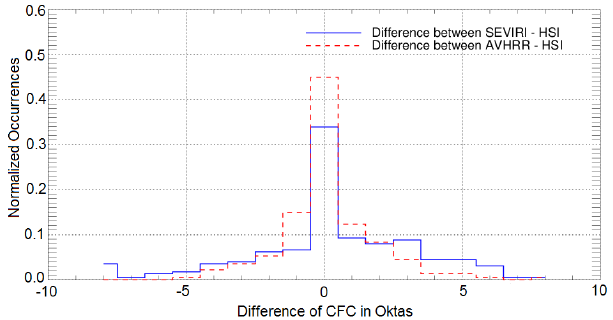
Figure 2. Occurrences of the instantaneous differences (blue solid line: SEVIRI minus HSI; red dashed line: AVHRR minus HSI) in oktas in Hannover from 1 July to 30 September 2009. Occurrences are normalized with their total count. Negative differences express an underestimation of the CFC by the satellites compared to HSI; positive differences express an overestimation. Table 2. POD clear , POD broken , POD cloudy , FAR clear , FAR broken and FAR cloudy (clear: cloud-free, broken: cloud-contaminated, cloudy: cloud-covered) in percent between HSI and SEVIRI in Han- nover, Germany, from 1 July to 30 September 2009; total of 1027 valid matches (not matched to AVHRR).